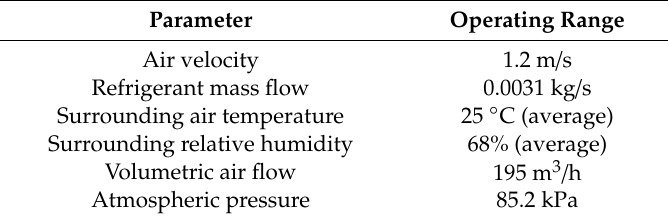
Table 3. Constant parameter during the